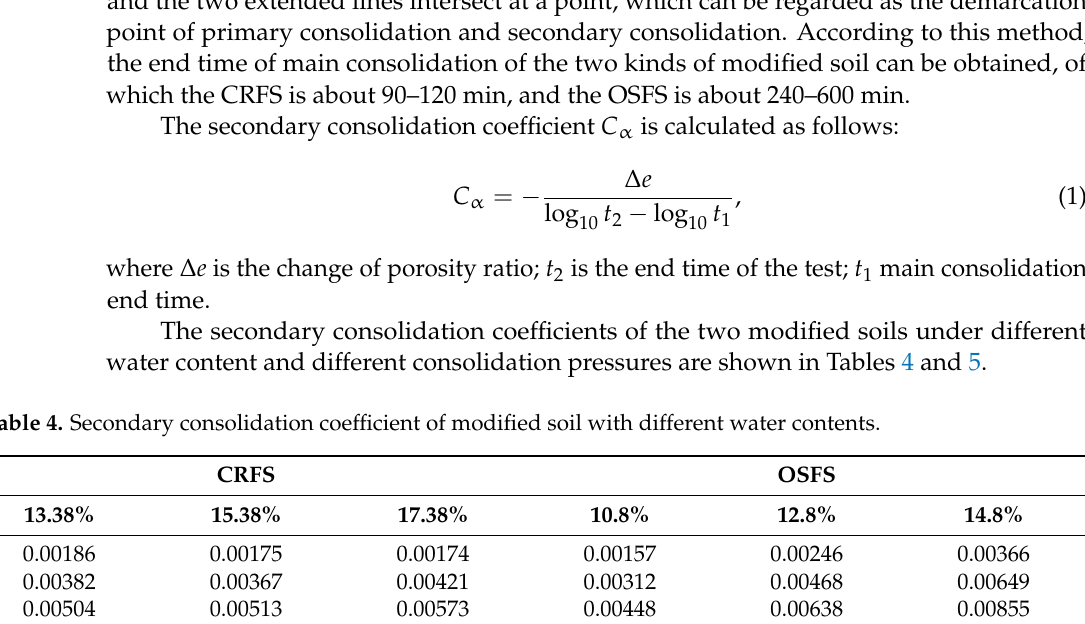
Table 5. Secondary consolidation coefficient of modified soil with different compaction degrees.